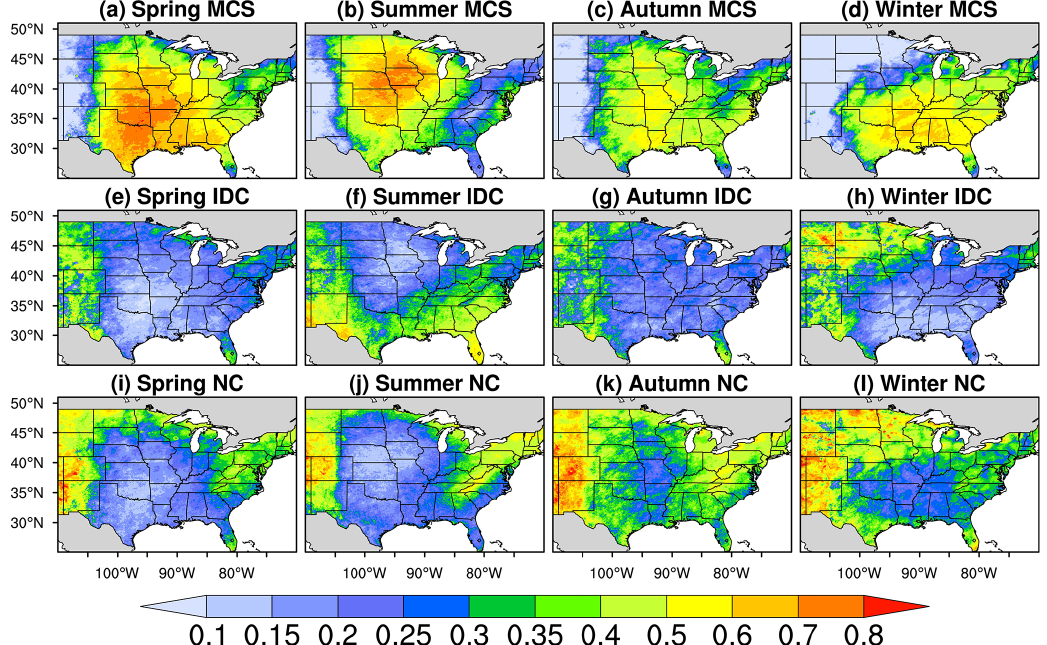
Figure A6. Distributions of the fractions of different types of precipitation in each season. Here, precipitation refers to annual mean seasonal amounts for 2004–2017. We exclude hourly data with precipitation ≤ 1mmh − 1 in the calculation. The first row is for total precipitation, the second for MCS precipitation, the third for IDC precipitation, and the fourth for NC precipitation. The first column shows spring precipitation, the second summer, the third autumn, and the fourth winter.